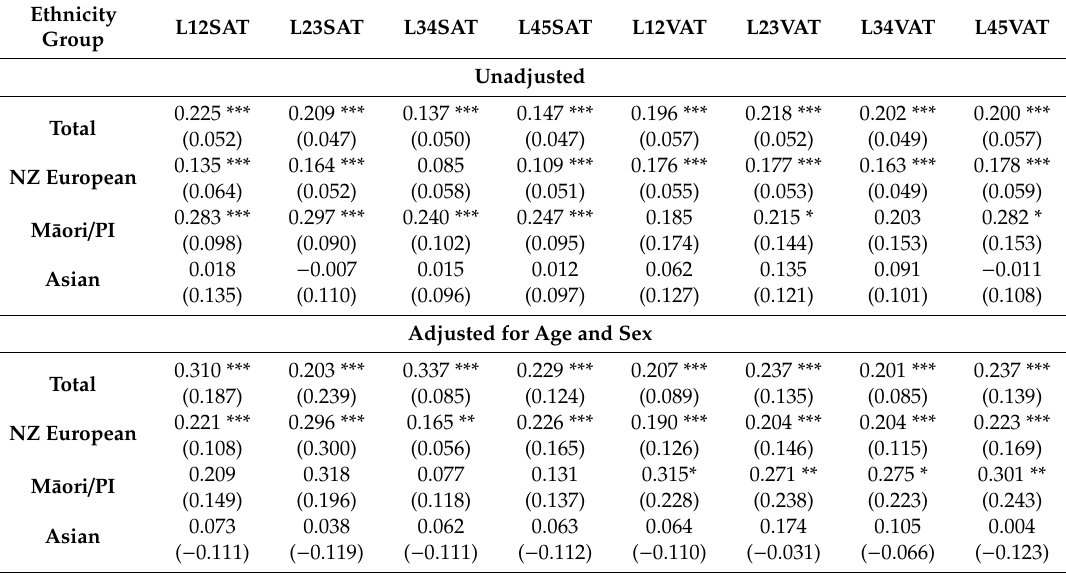
Table 3. Regression result for ethnicity-specific associations between BMI and fat